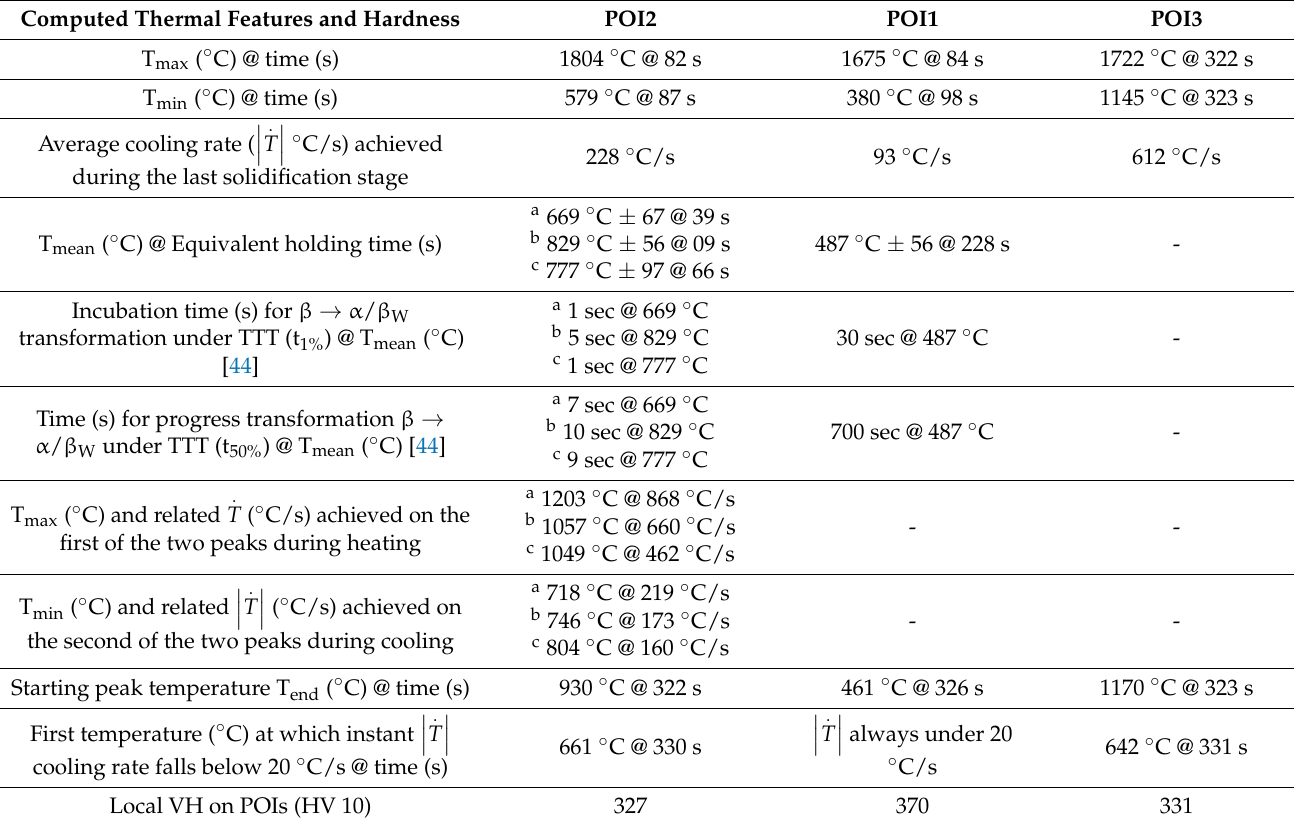
Table 4. Thermal characteristic and time-based features related to TTB1 to TTB4 as calculated by simulated thermal histories of the three POIs and related local Vickers hardness (VH)